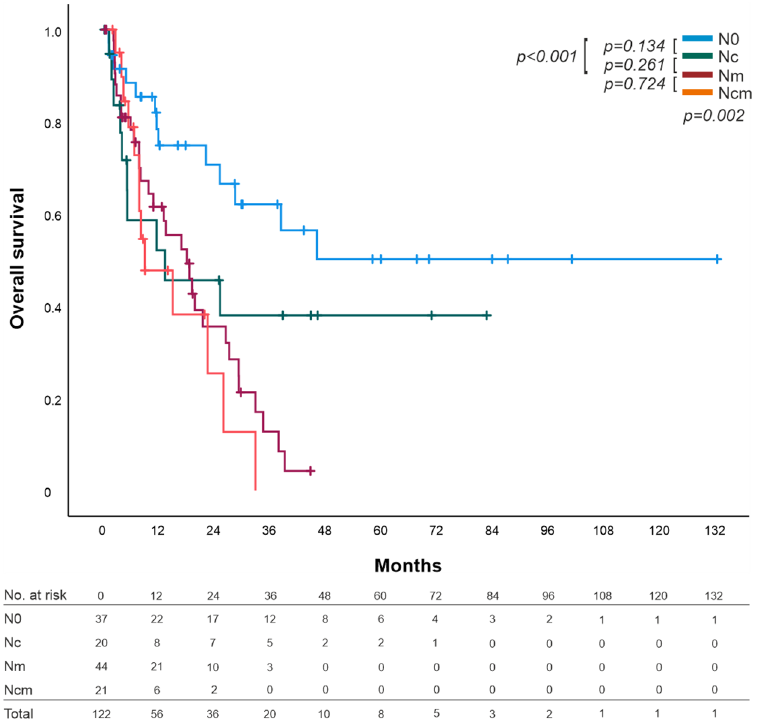
Figure 2. Overall survival (OS) of patients with PDAC distinguished by node-negative (N0), per continuitatem (Nc), lymph node metastasis (Nm), and combination of per continuitatem and lymph node metastasis (Ncm). Overall statistical significance difference was p = 0.002; no statistical significance difference between N0 and Nc ( p = 0.134); a significant statistically difference between N0 and Nm was found ( p ≤ 0.001); Nc and Nm showed no statistically significant difference, but their curves diverged strongly ( p = 0.261). No statistically significant difference between Nm and Ncm was found ( p =